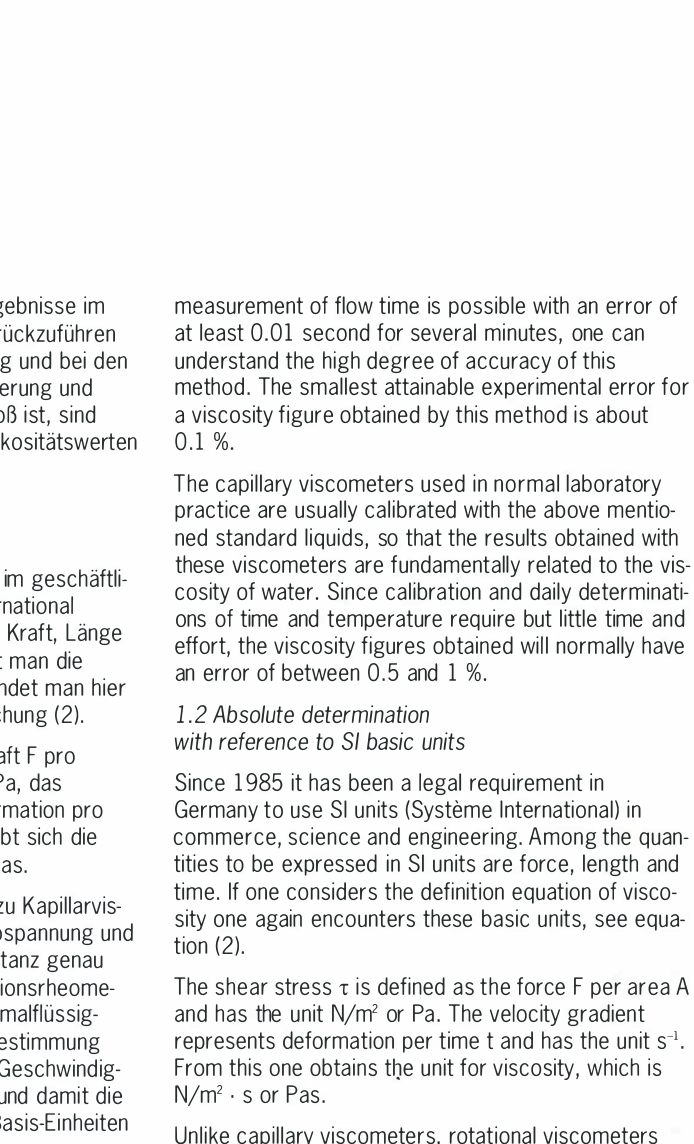
Fig. 1: Design drawing for a measuring